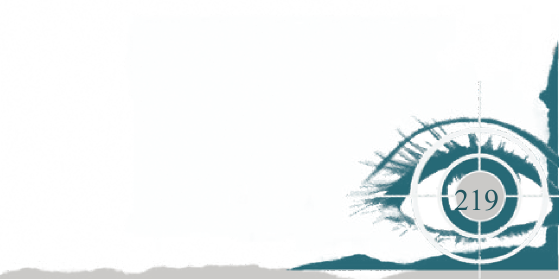
Figure 4: OCT image of right eye showing no areas of subretinal fluid, no elevation of the choroid and no retinal thickening. The scan was taken in vertical orientation and passing through the fovea (the inferior retina is to the left on the